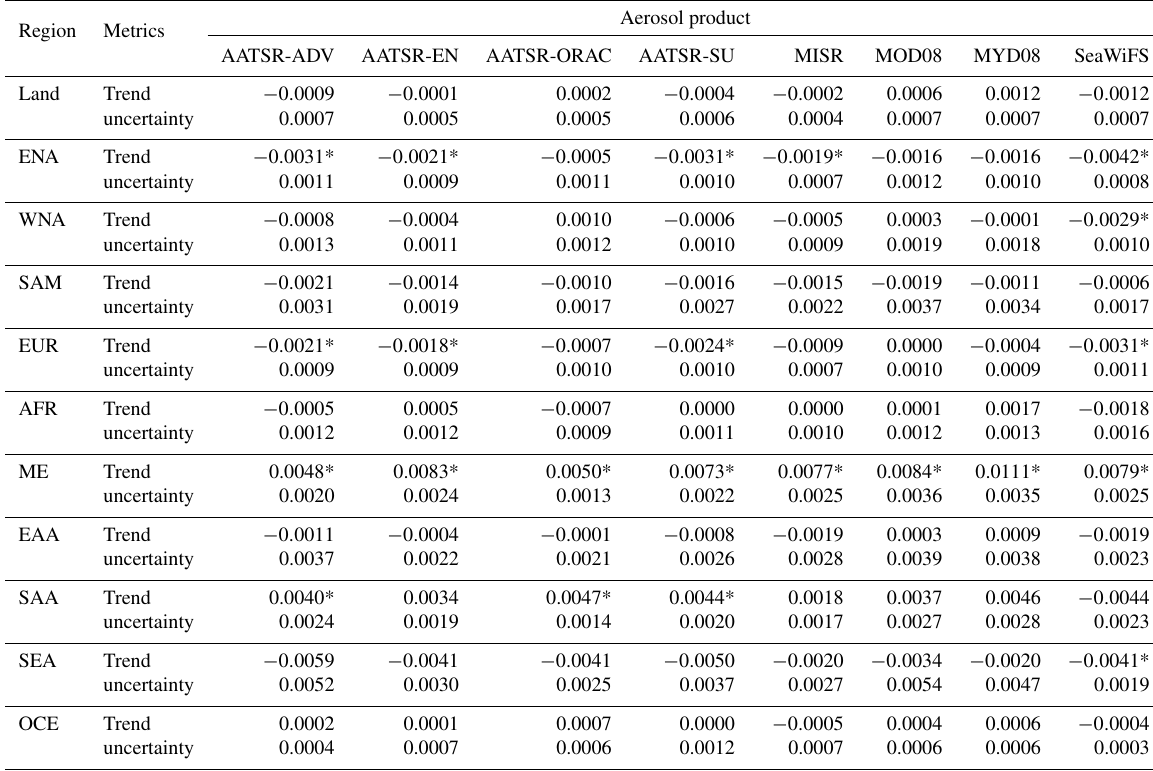
Table 4. Regional temporal trends and uncertainties derived from eight AOD products for the period 2003–2010 over land, where * indicates trends significant at 95% confidence level.